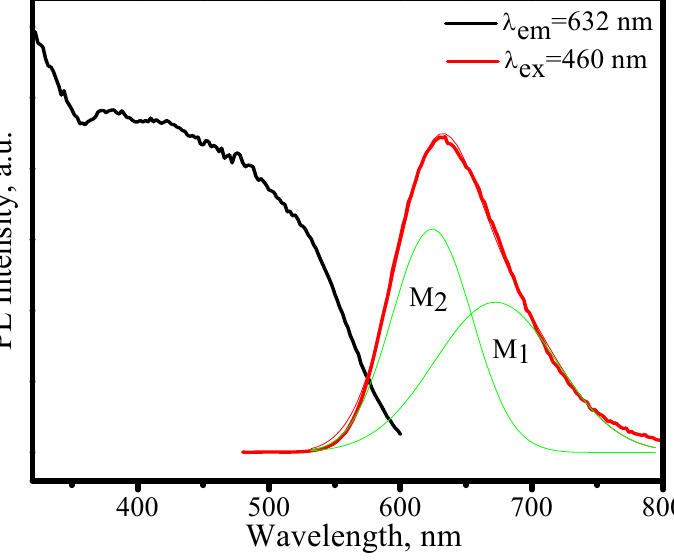
= 460 nm) and excitation ( λ ex